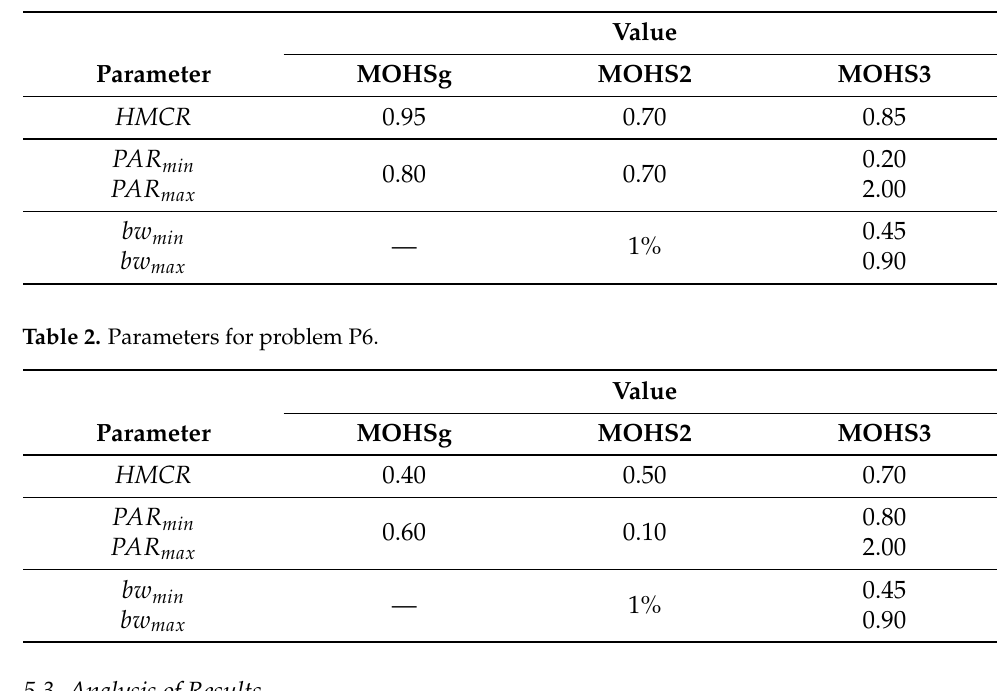
Table 1. Parameters for problems P1 to P5.